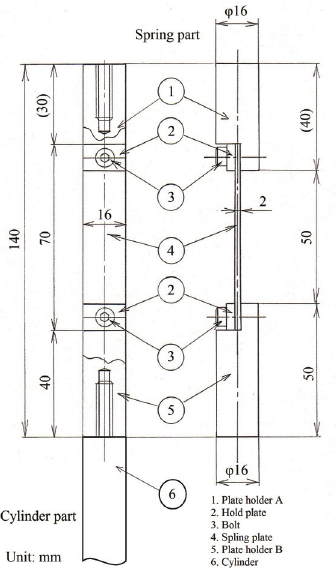
Fig. 1. The schematic drawing of a test cylinder spring section